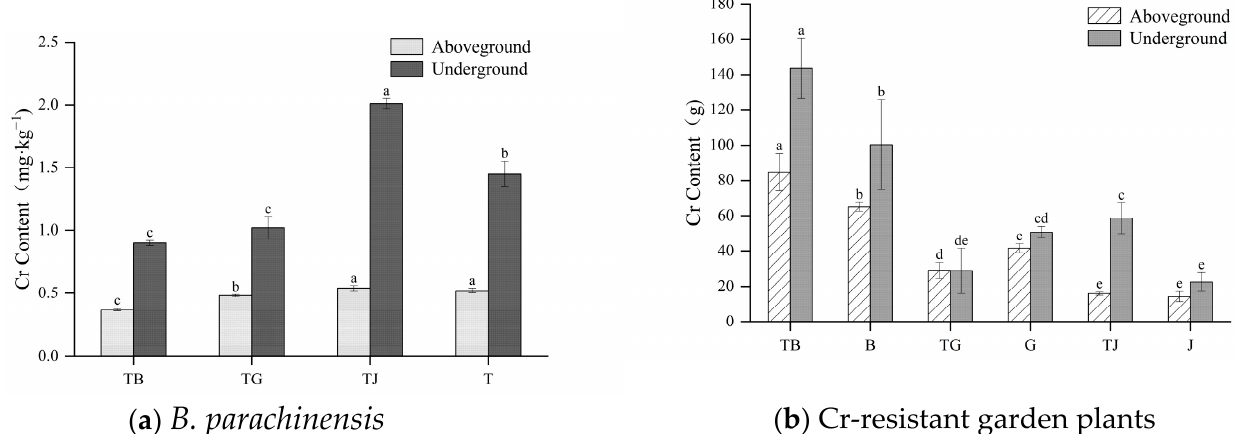
Figure 3. Cr content of plants under different treatments. Note: different letters in the same column